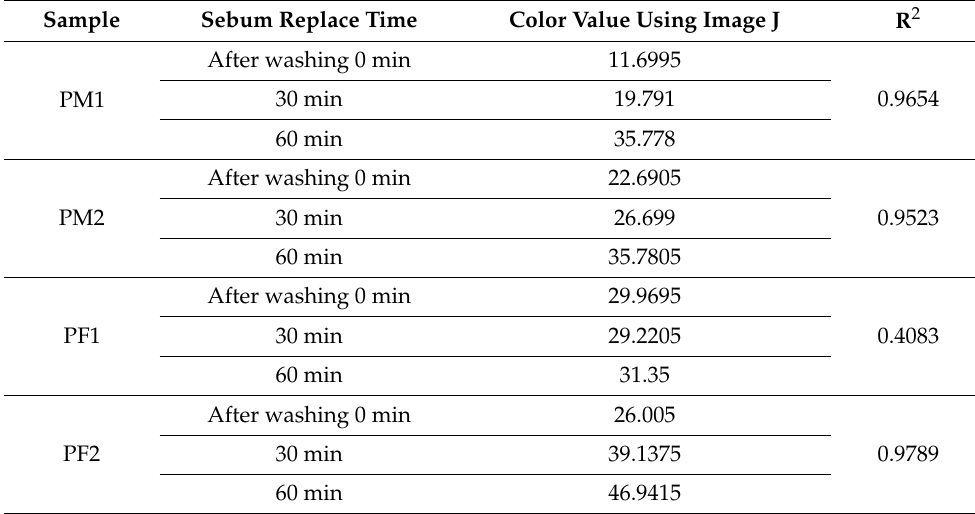
Figure 2. Correlation between the sebum replace time and ORO-stained color intensity. ( a ) ORO- stained sebum color intensity collected from PVC film by sebum replacement time. ( b ) The coefficient of determination from digitalized color value using ImageJ. ( c ) CIE diagram from chromaticity values. Table 1. Comparison of ORO-stained color intensity and intensity using the TCS 3200 color sensor on sebum replacement